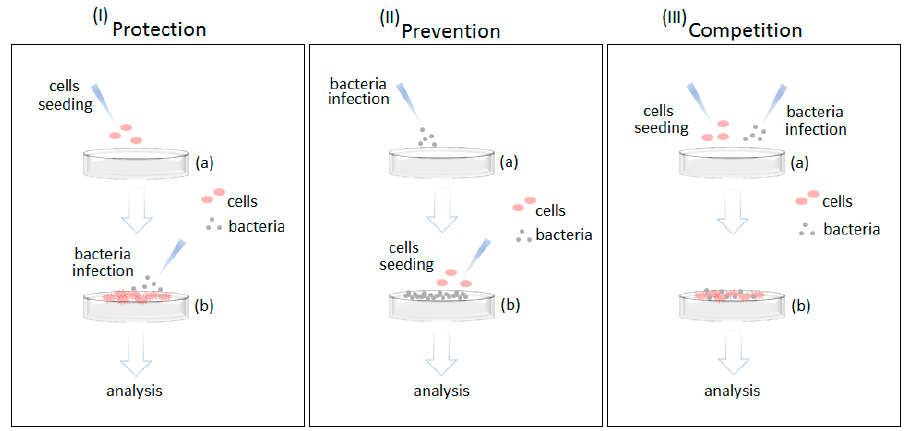
Figure 1. Schematic representation of the three cells–bacteria co-culture methods.